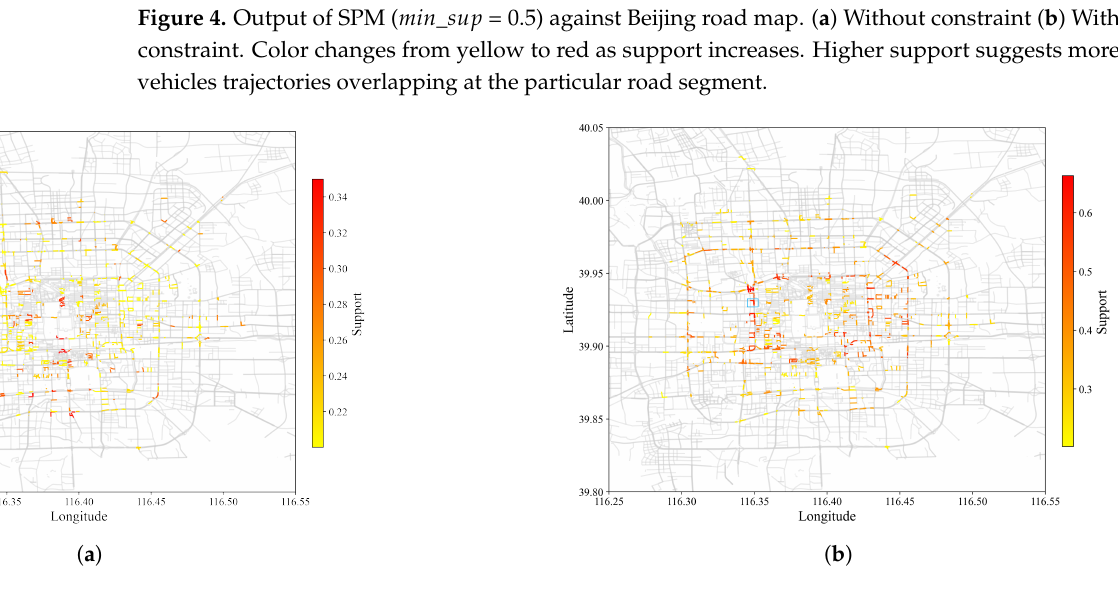
Figure 5. Output of SPM ( min _ sup = 0.2) against Beijing road map. ( a ) Without constraint ( b ) With constraint. Color changes from yellow to red as support increases. Higher support suggests more vehicles trajectories overlapping at the particular road segment.